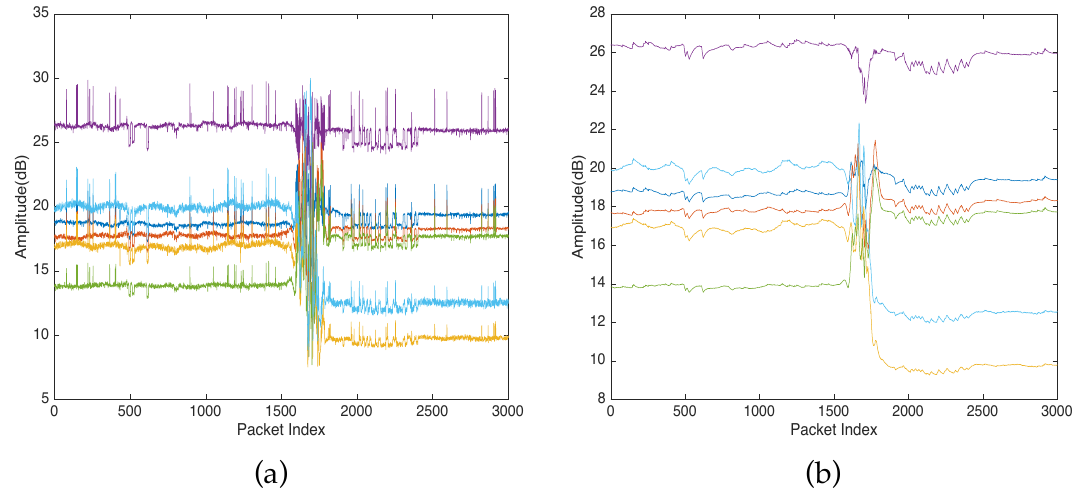
Figure 2. Extracted Channel State Information (CSI) streams from fall experiment. ( a ) Original CSI streams; ( b ) CSI streams after exponential